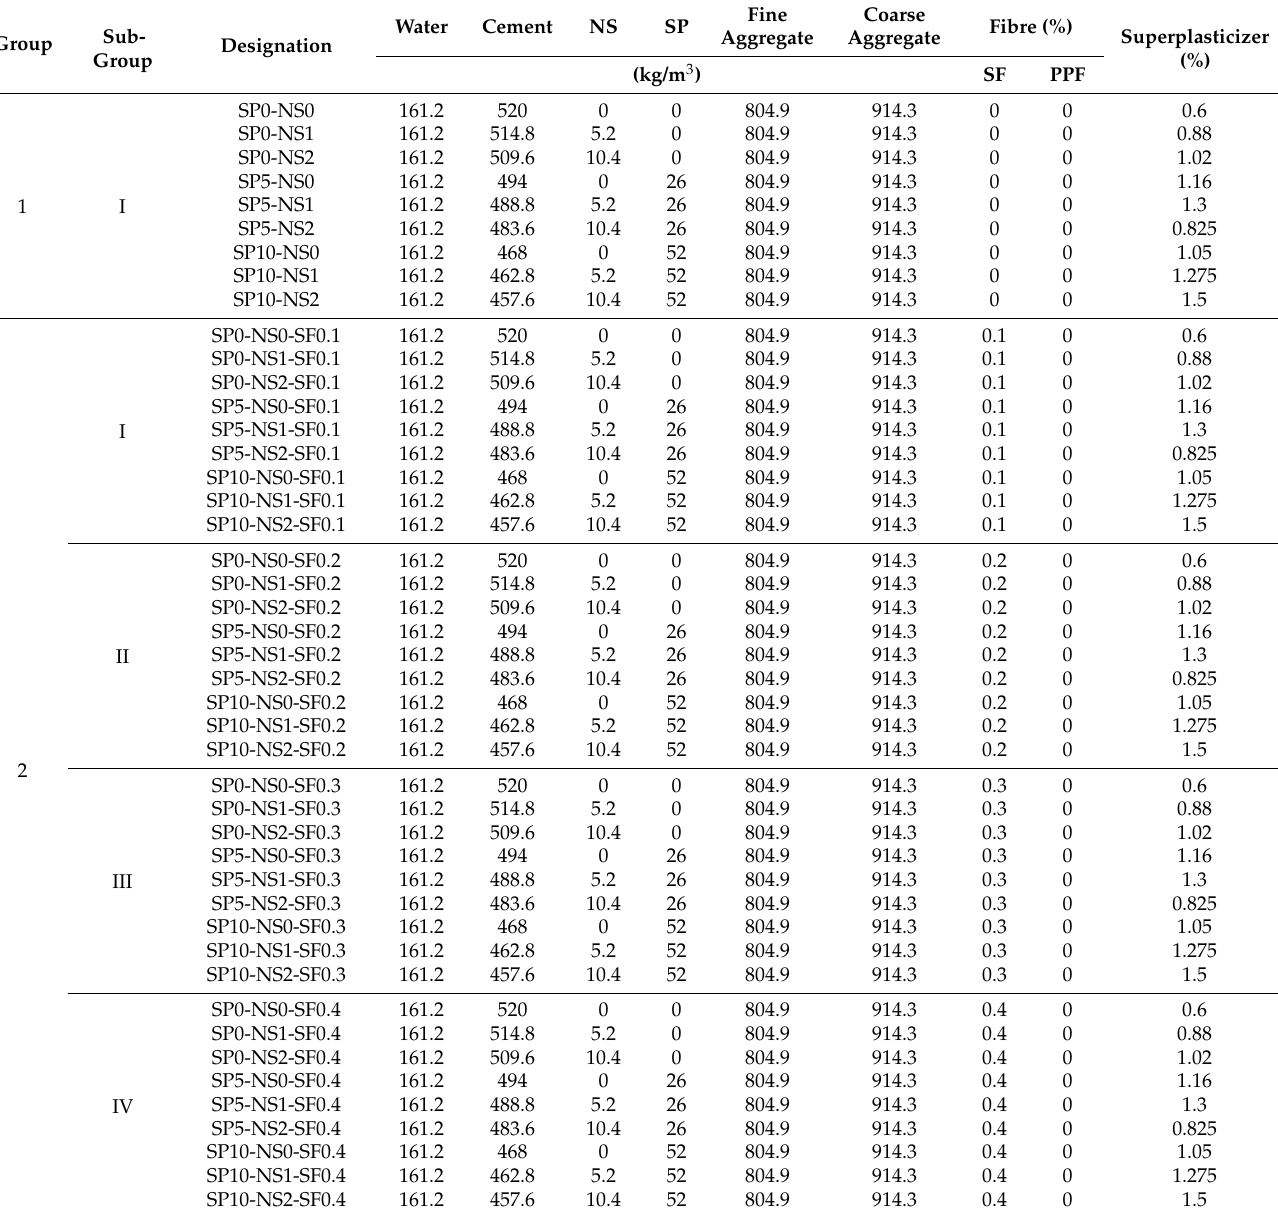
Table 8. Concrete mixes